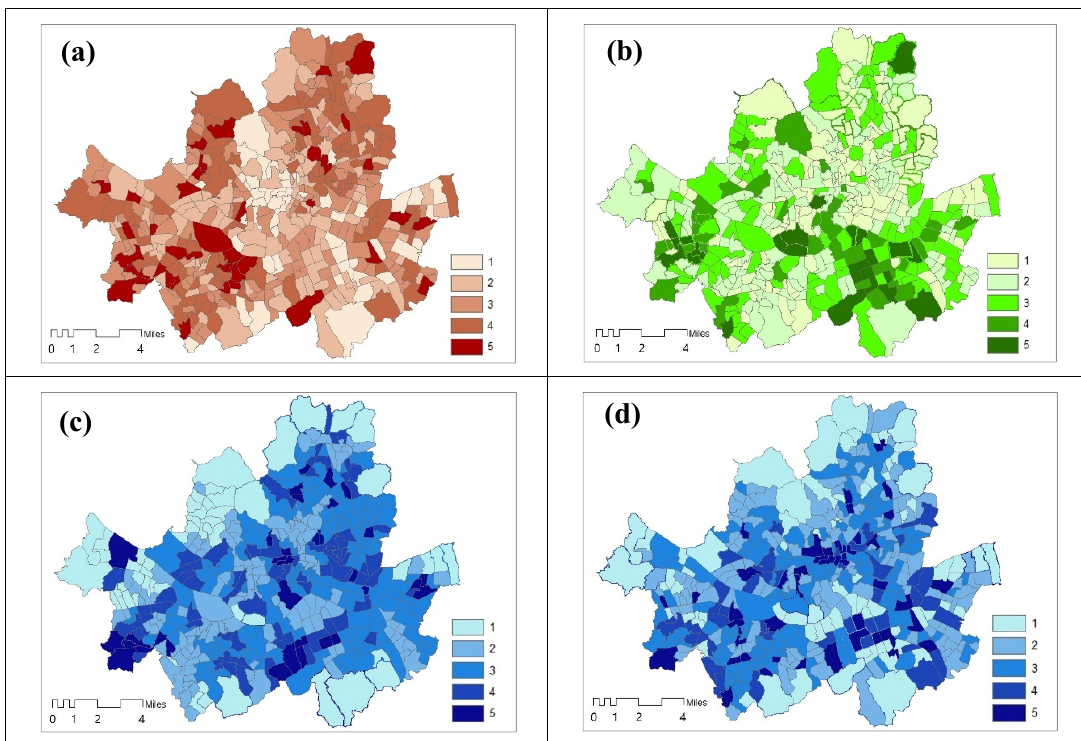
Figure 3. Three indices of temperature and sensible heat flux. Note: ( a ) Sensitivity to both temperature and sensible heat; ( b ) Adaptive capacity to both temperature and heat; ( c ) Exposure to temperature; ( d ) Exposure to sensible heat; Standardised value class (range): 1 (0~0.20), 2 (0.21~0.40), 3 (0.41~0.609), 4 (0.61~0.80), 5 (0.81~1.00).